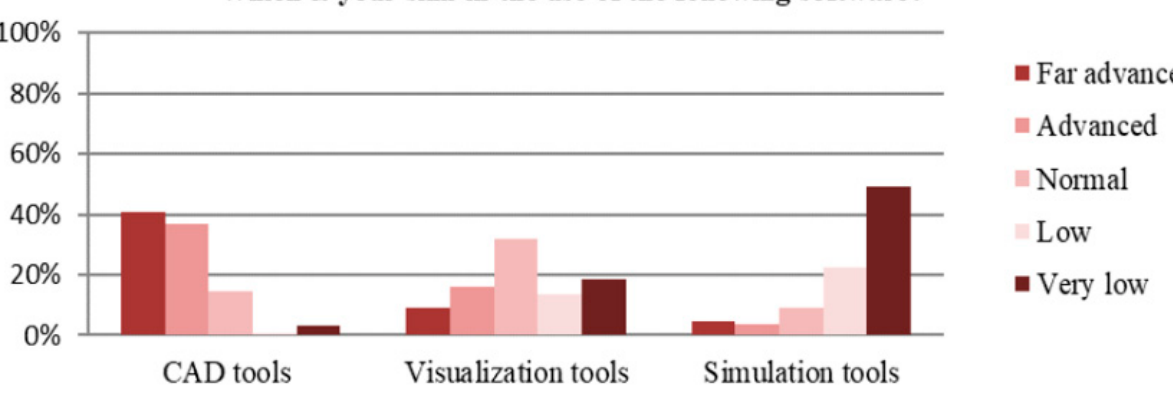
Figure 4. Tools used during the design stage and users’ skills.